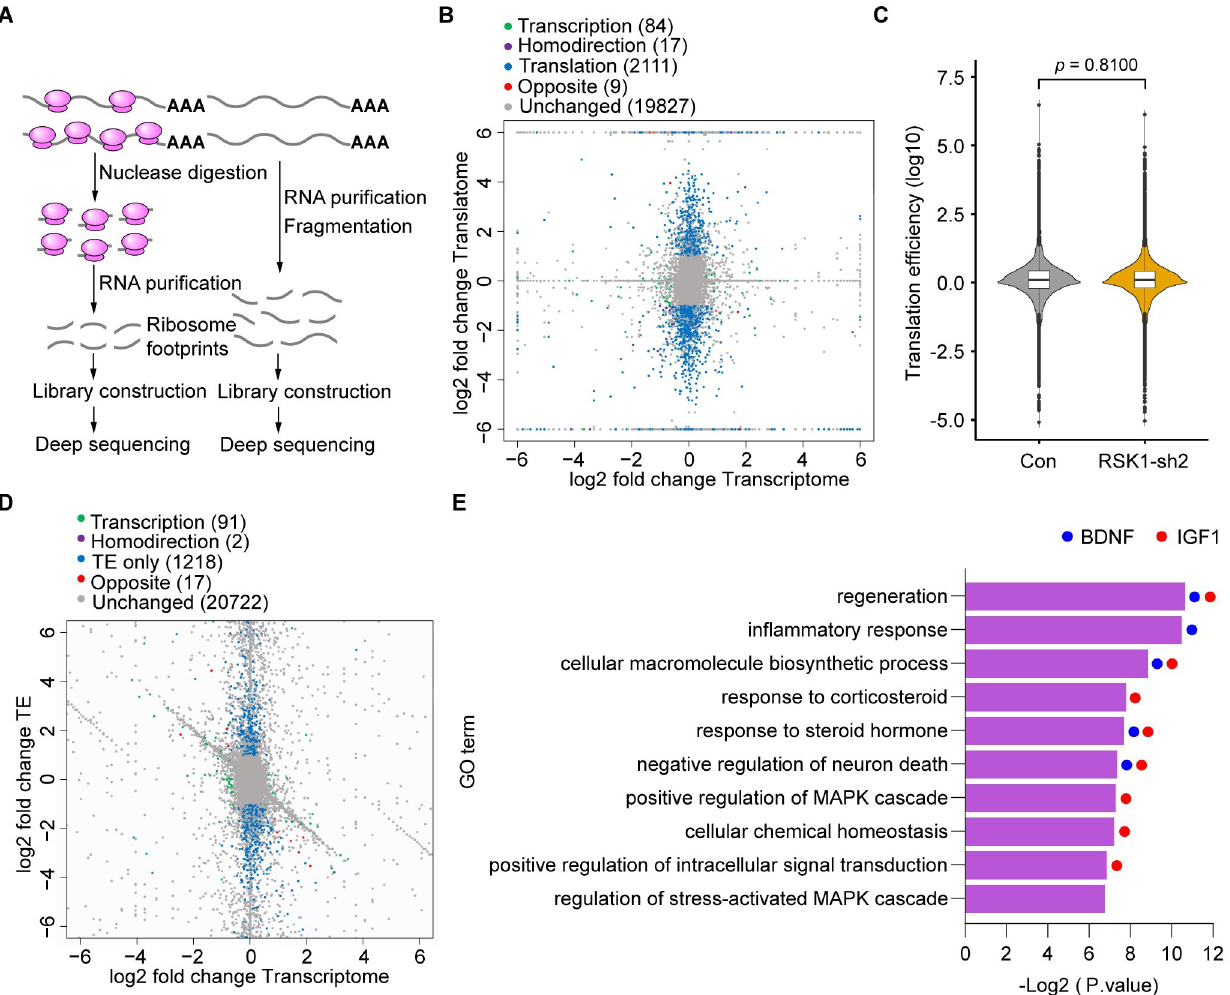
Fig 6. KD of RSK1 impairs the synthesis of regeneration-related proteins. (A) Experimental workflow of Ribo-seq. (B) Scatter plot of differentially expressed translatome and transcriptome between neurons infected with AAV2/8-RSK1-sh2 (RSK1 KD) or control shRNA AAV. (C) TE of mRNAs in neurons infected with RSK1 KD or control shRNA AAV. Box plots show mean and standard deviation within each group; violin plot shows the gene density at each y-axis value; p -value was calculated using the 2-sided Wilcoxon rank-sum test. (D) Scatter plot of genes with significant differential TEs between neurons with and without RSK1 KD. The TEs of the transcripts were calculated as the ratio of reads of RPFs to the total mRNA abundance. (E) Intersection of the results from GO analysis using DAVID and GO Resource of the differentially expressed genes with down-regulated TEs in the TE only and Opposite groups from (D) to determine which signaling/effector pathways are enriched with RSK1 KD. BDNF and IGF1 are indicated in each GO term in which they are involved by blue and red dots, respectively. The data underlying the graphs shown in Fig 6C and 6E are included in S1 Data. The data underlying the graphs shown in Fig 6B and 6D are included in the S1 and S2 Tables respectively. GO, Gene Ontology; KD, knockdown; RPF, ribosome- protected fragment; RSK1, ribosomal S6 kinase 1; TE, translation